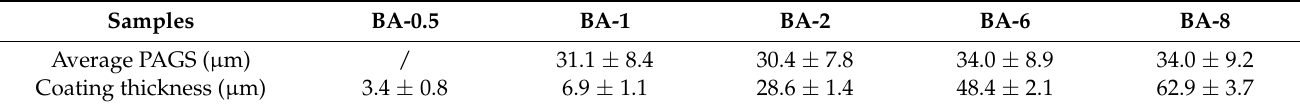
Figure 3. SEM images to measure the prior austenite grains of boro-austempered samples with var- ied boriding time: ( a ) 1 h; ( b ) 2 h; ( c ) 6 h; ( d ) 8 h. Table 2. Average PAGS and coating thickness of different boro-austempered samples.